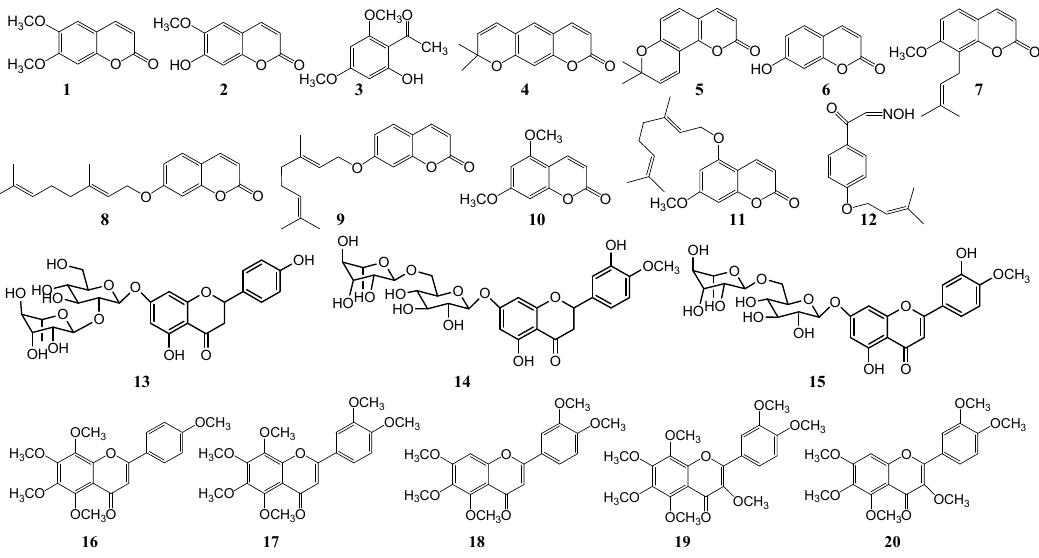
Figure 1. Chemical structures of antifungal constituents 1–20 .